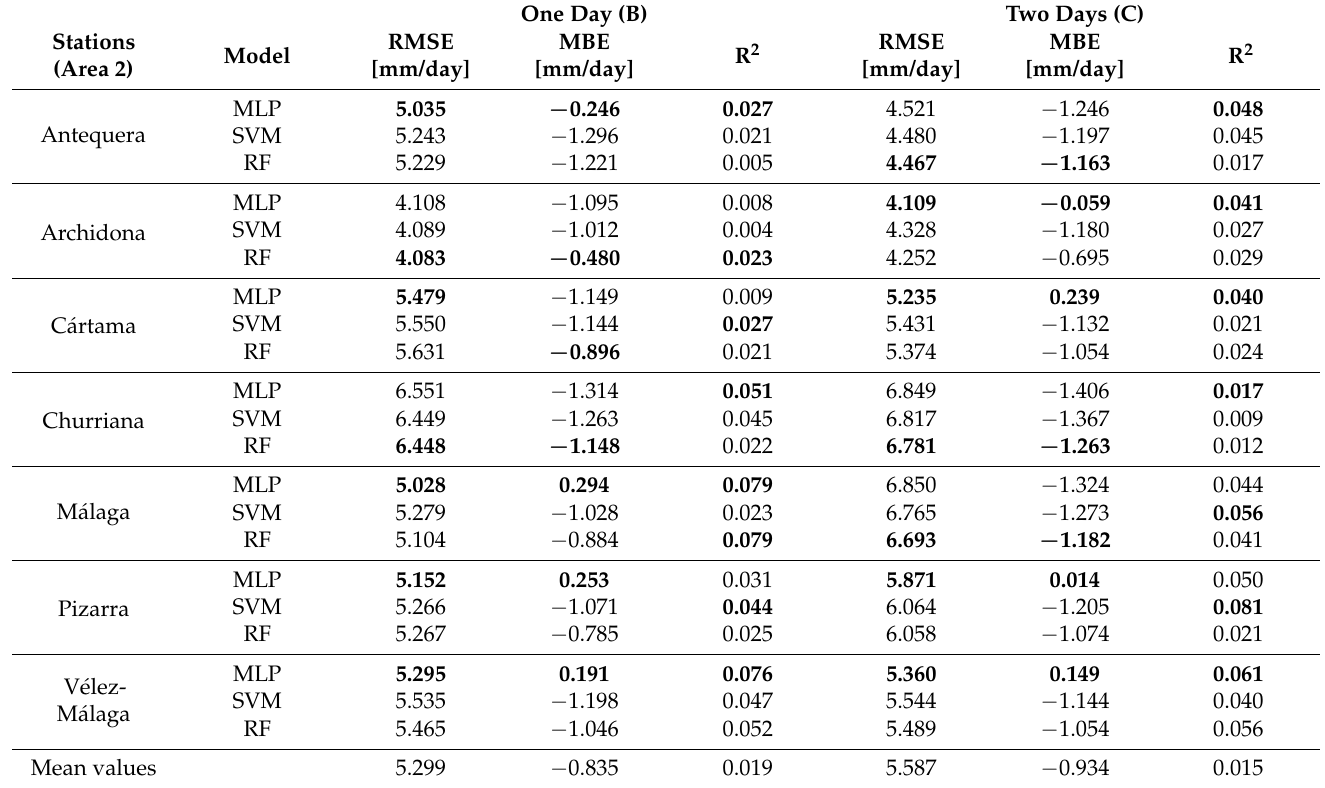
Table 7. RMSE, MBE, and R 2 performance values from testing dataset for all locations and models in the second area (coastal locations), using data from the target station in two different approaches, with the use of the previous and following day and the use of the two previous and two following days. The best values from each station are in